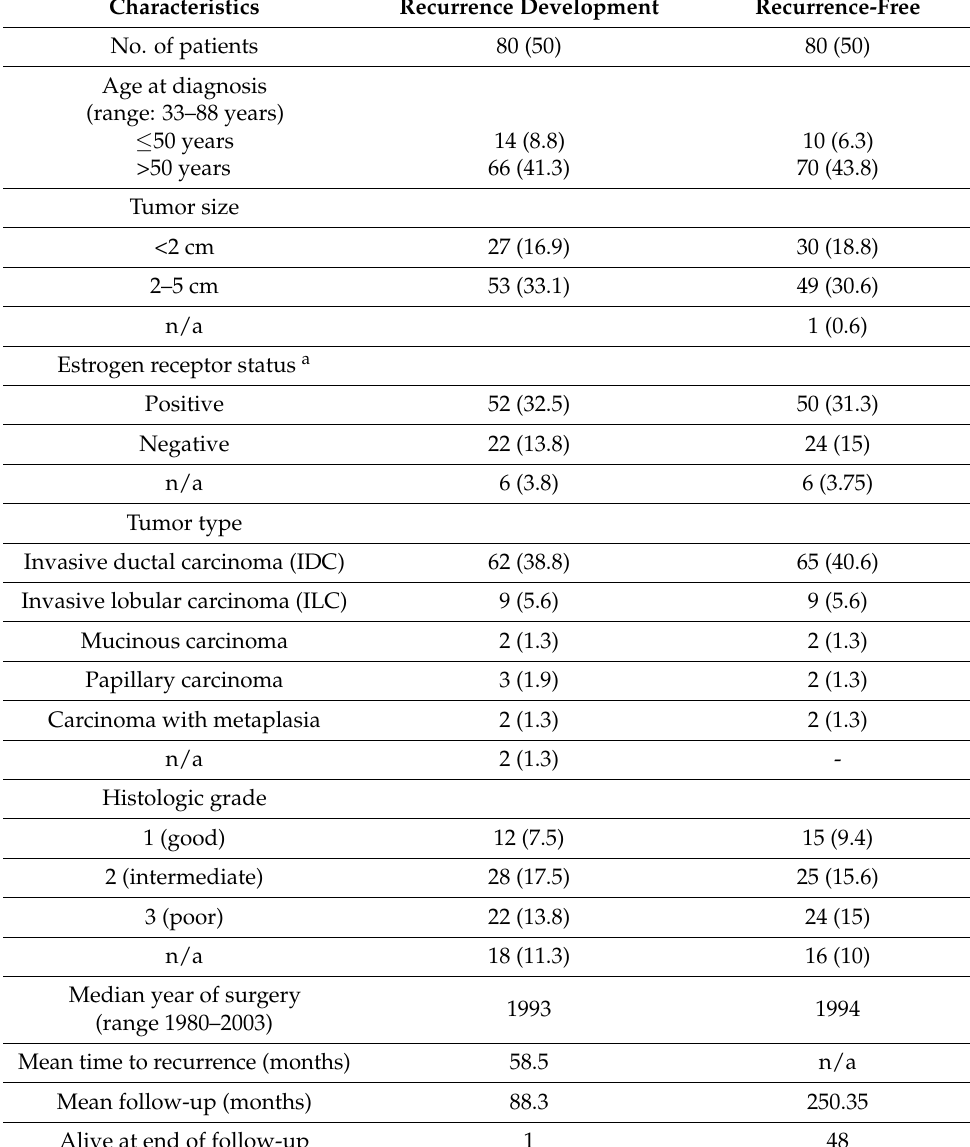
Table 1. Patient and tumor